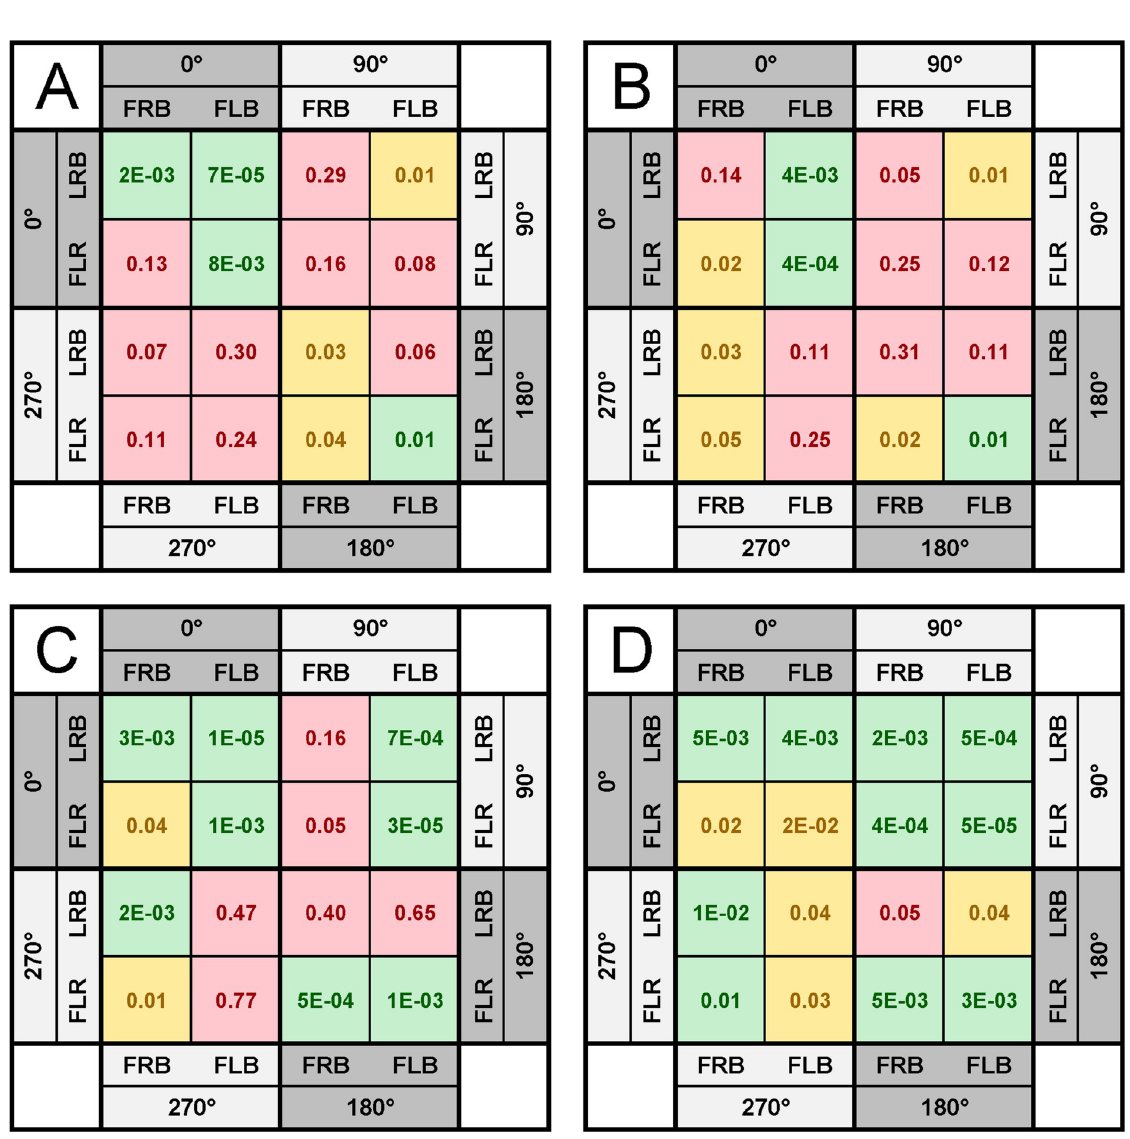
Fig 6. The heat map illustrating the statistical significance thresholds for the comparison of the averages of three sensors. The comparison of the groups where FRONT or BACK were excluded (LRB or FLR, respectively) against groups where LEFT or RIGHT sensors were excluded (denoted as FRB or FLB, respectively) from the calculations. The averages of the peak overpressure (A, C) and impulse (B, D) of the waveforms recorded at 5 psi (A, B) or 10 psi (C, D) nominal BOP are presented. The multiple pairwise comparison was performed only at specific headform-helmet orientation: 0˚ (upper left quadrants), 90˚ (upper right quadrants), 180˚ (lower right quadrants), and 270˚ (lower left quadrants). The following p-value thresholds were used: p < 0.001 (green), 0.05 < p < 0.001 (yellow), p > 0.05 (red) to construct the heat